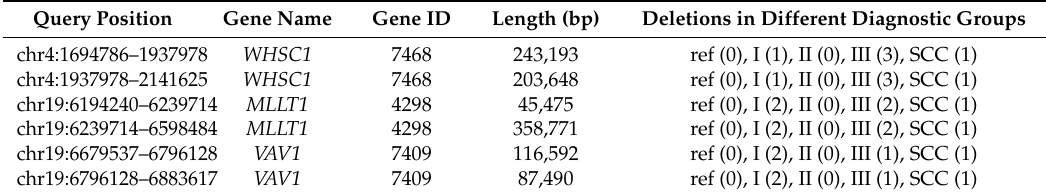
Table 4. Newly-identified CNAs (deletions) contain known oncogenes in cases only.